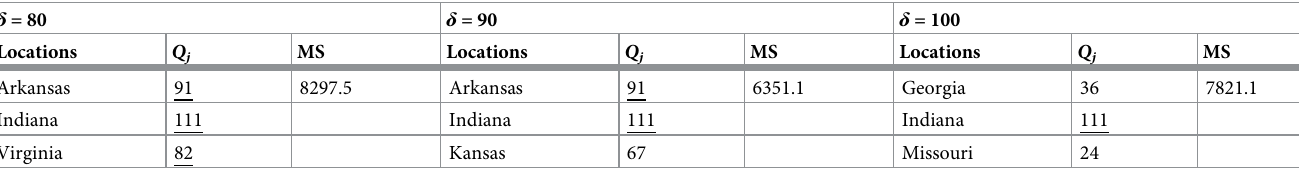
= 40, R = 80, γ 1 = 0.4, γ 2 = 0.6). c q